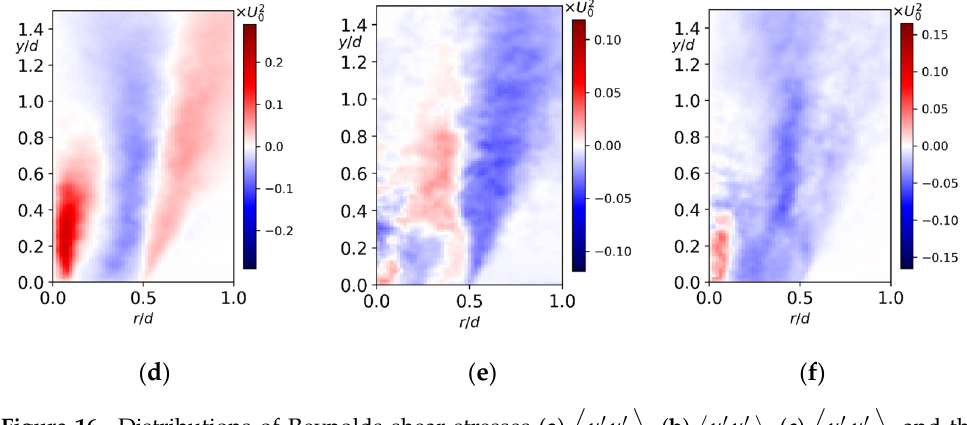
Figure 16. Distributions of Reynolds shear stresses ( a ) corresponding stochastic parts ( d )